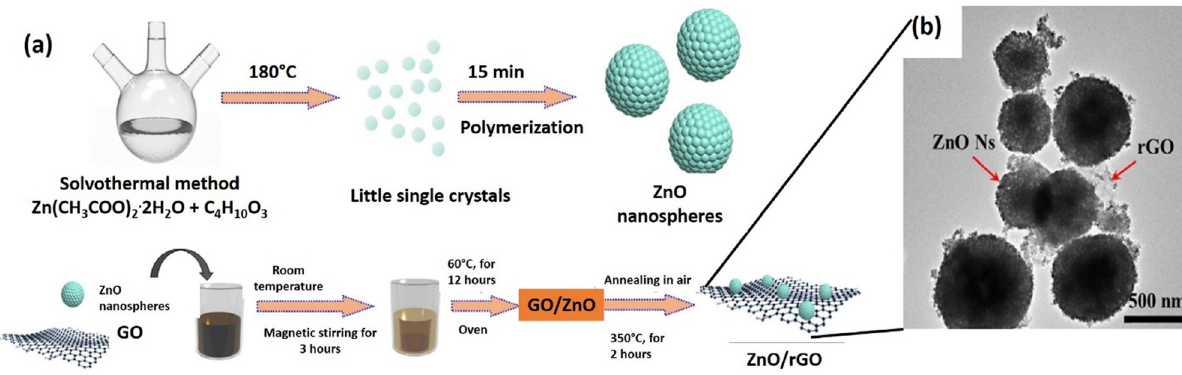
Figure 26: ( a ) schematic diagram for the synthesization of ZnO nanospheres by solvothermal method and the formation of rGO/ZnO heterostructure, and ( b ) rGO/ZnO image under FESEM at 500 nm. Reproduced from ref. [ 172